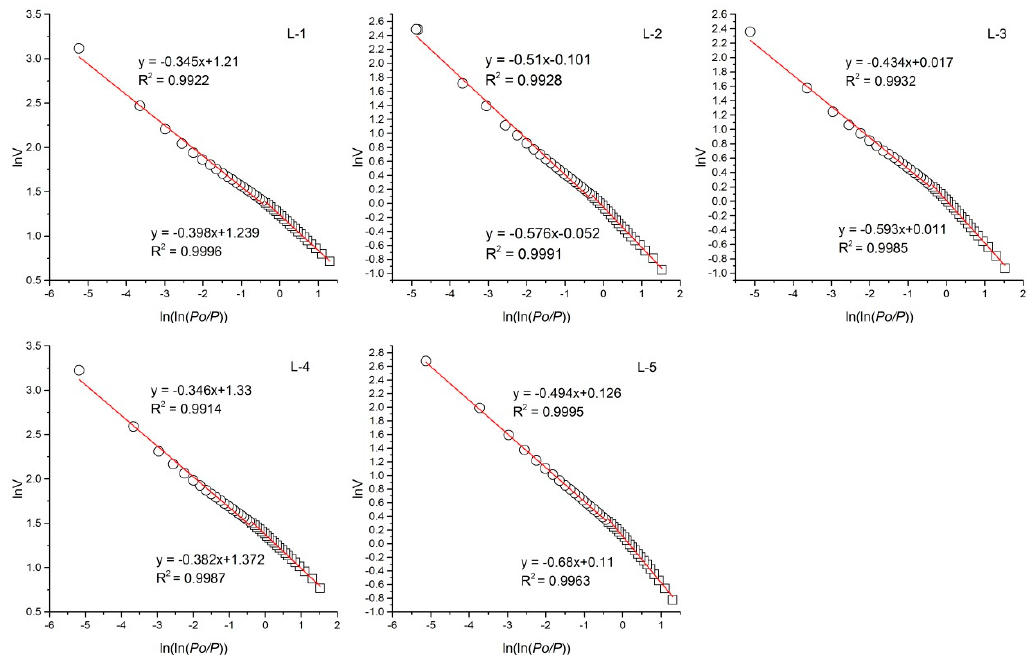
Figure 8. Fractal dimension calculation results with ln V versus ln(ln( P o / P )) from N 2 adsorption isotherms ( P / P o from 0.01 to 1). Notice that we use different shapes of points to represent the fitting data of two parts. The hollow rectangles denote the fractal dimension D 1 , and the hollow circles indicate the fractal dimension D 2 . R 2 is the correlation coefficient.